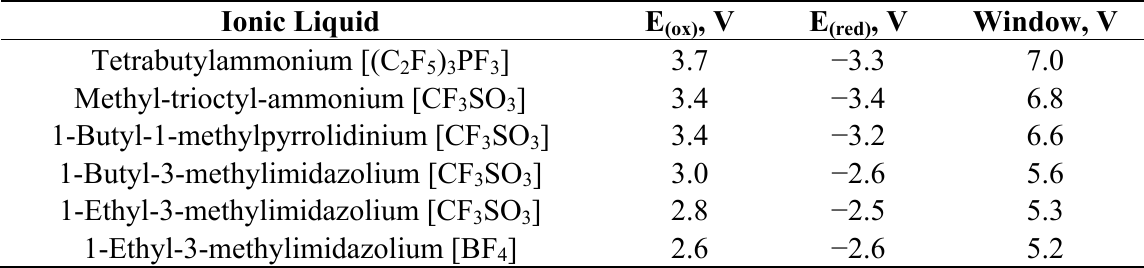
Table 2. Electrochemical stability of triflate ionic liquids in comparison to the ionic liquids with [(C F ) PF ] and [BF ] anions. 2 5 3 3 4